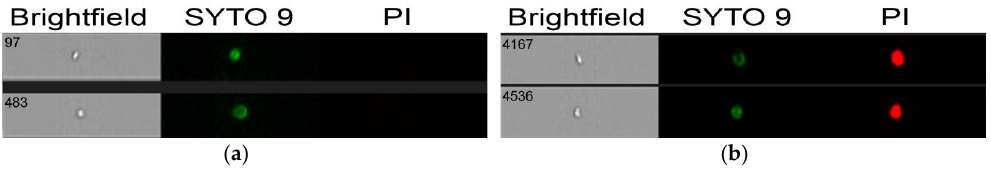
Figure 2. Flow cytometry analysis of E. faecalis cell-suspension after 60 min incubation with G-ænial Bond (a single experiment example). ( a ) Cells labelled green (SYTO9+); ( b ) Cells labelled red (PI).